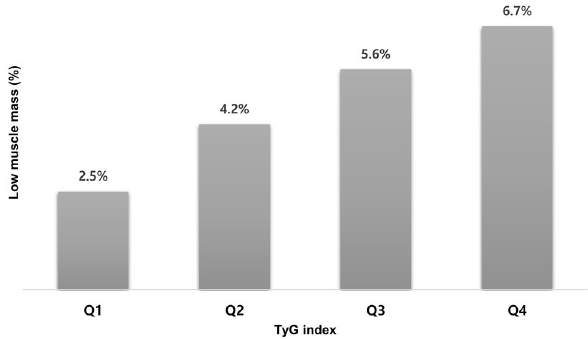
Figure 2. Prevalence of low muscle mass according to quartiles of the TyG index. TyG index triglyceride- glucose index.